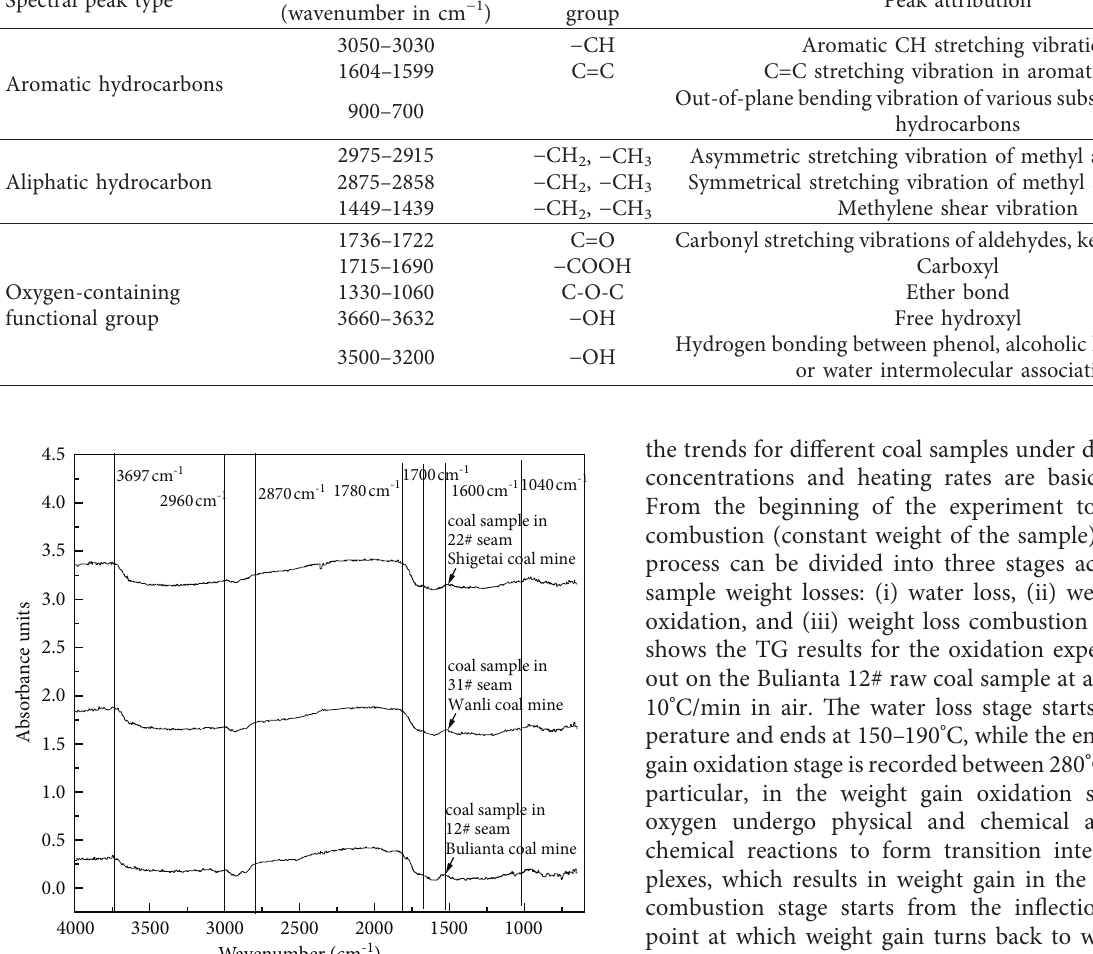
Table 1: Main characteristic peaks of the IR spectrum of interest for the present work [13]. Spectral peak type